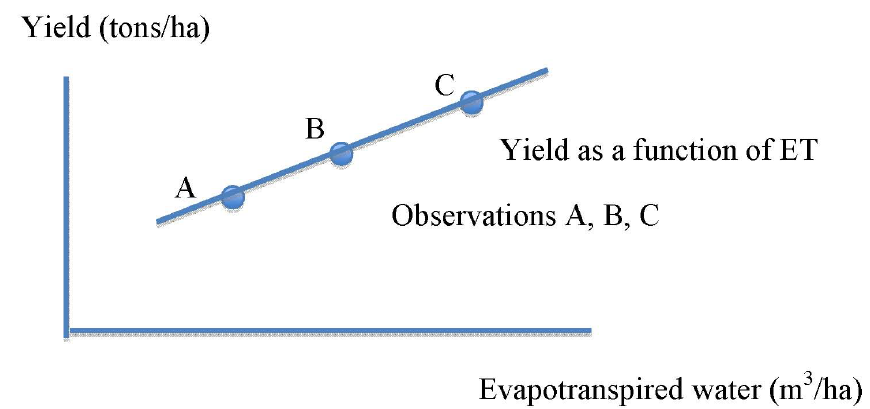
Figure 8. Comparing observations of water productivity, with respect to ET.